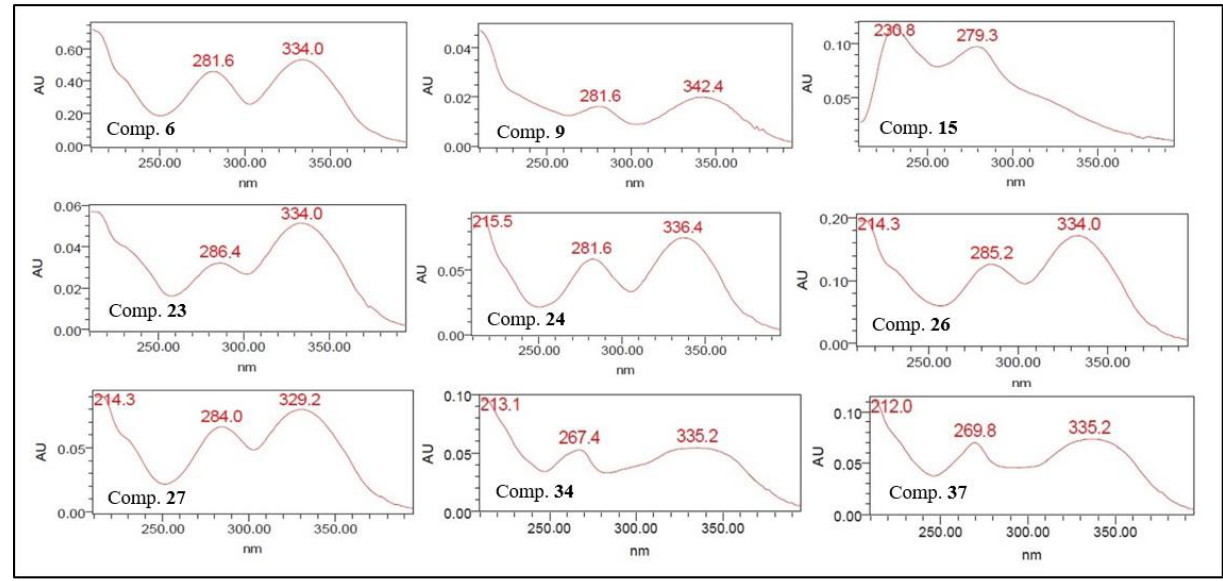
Figure 2. UV spectra (200 – 400 nm) of flavonoids present in the ethanolic extract of F. chica leaves. Desoxyanthocyanidins are widely reported in extracts of this plant, imparting a red color to the extract [1]. In the present study, four anthocyanidins were identified, present as protonated species with [M + H] + m/z values of 301.0707, 285.0761, 315.0807 and 299.0918, attributed to the anthocyanidins 3 (cid:48) -hydroxy-carajurone (15), carajurone (19), 3 (cid:48) -hydroxy- carajurin (32) and carajurin (38), respectively. In the fragmentation analysis, losses due to demethylation, decarboxylation and dehydration were observed. Furthermore, fragments resulting from retro-Diels–Alder-type breaks were observed. Fragmentation data for each compound are shown in Table 1 and Figure 3. These anthocyanidins have been previously isolated from leaf extracts of this species